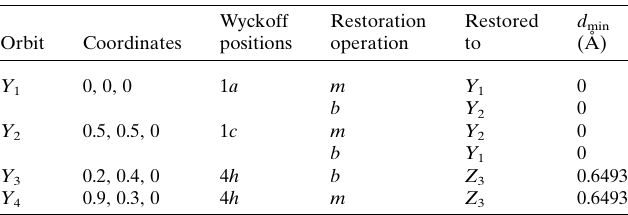
Table 4 Analysis of the split orbits Y j stemming from Y under H = P (cid:2) 44. Same conventions as in Table 3.